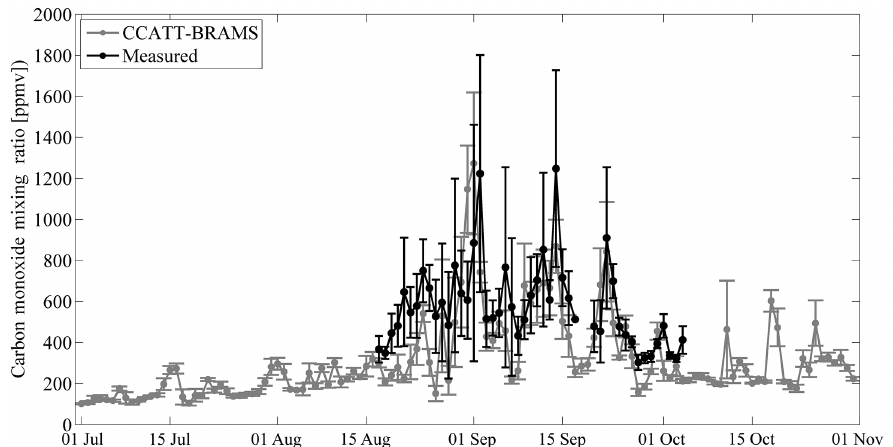
Figure 11. Time series of mean daily values of the mixing ratio of carbon monoxide measured at an Amazonian ground station (Porto Velho) and from CCATT-BRAMS